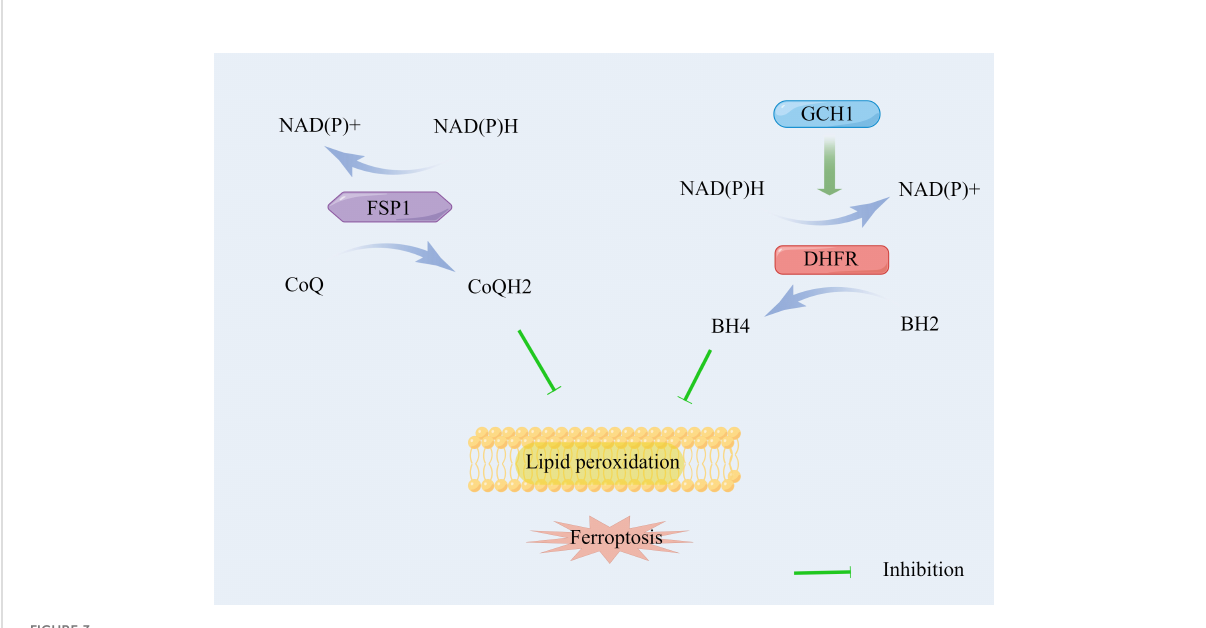
FIGURE 3 The signaling pathways of ferroptosis independent of SLC7A11/GSH/GPX4